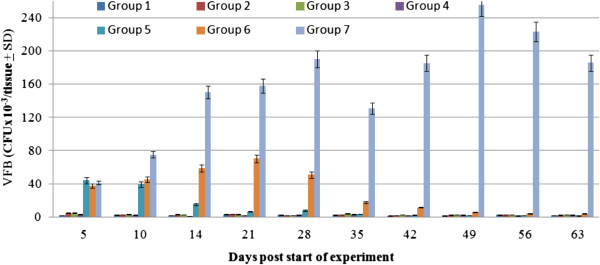
Vaginal fungal burden in control and experimental mouse groups at different time points during the experiment. Data represented is the average vaginal fungal burdenx10-3/mouse ± SD as obtained from three separate experiments.